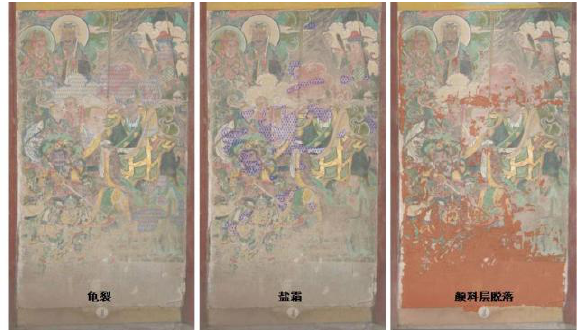
Figure 2125 degradation map of mural yi fu fo hui